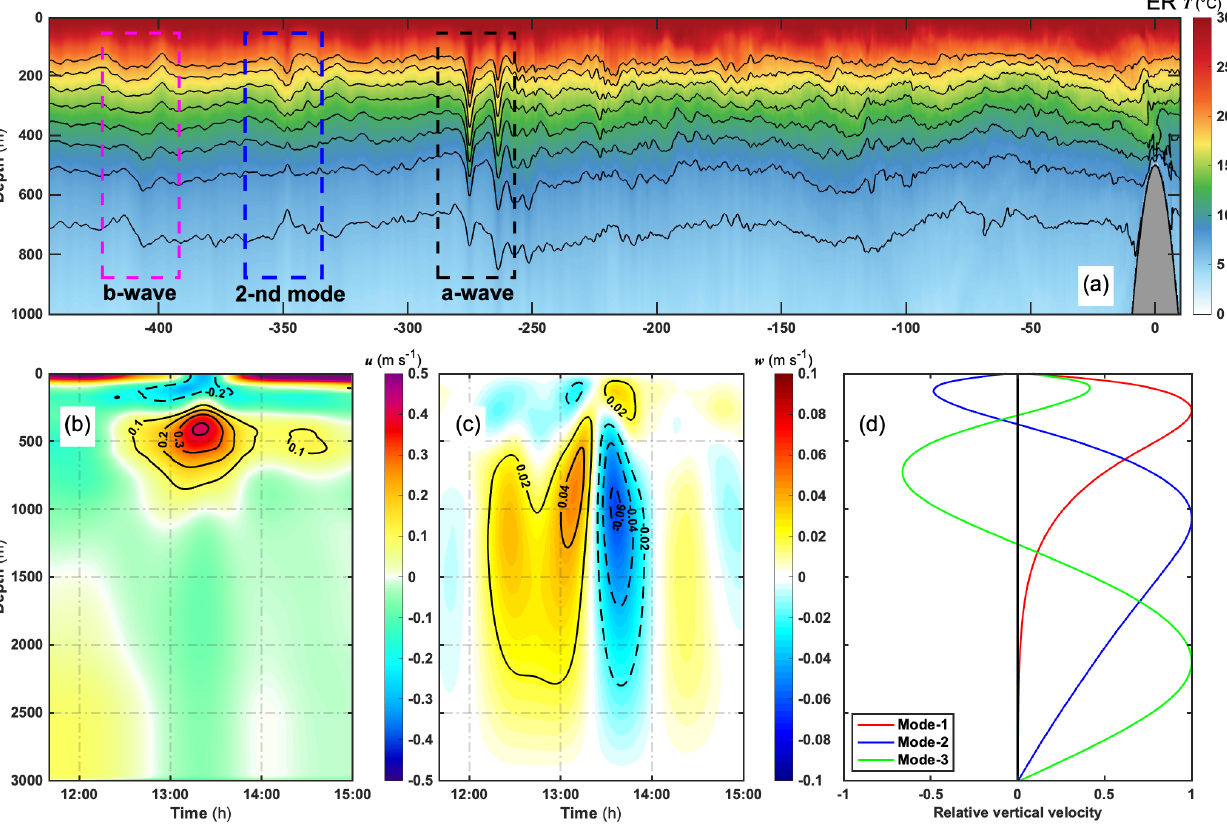
Figure 21. (a) The temperature ( ◦ C) field from the west side of the east ridge at 13:00 on the seventh day; dashed rectangles refer to the respective wave types. (b) The horizontal baroclinic velocity (ms − 1 ) and (c) vertical velocity (ms − 1 ) structures of the second-mode ISW at x = − 350km. (d) The normal-mode profiles about vertical velocity for the first three modes using the Taylor–Goldstein